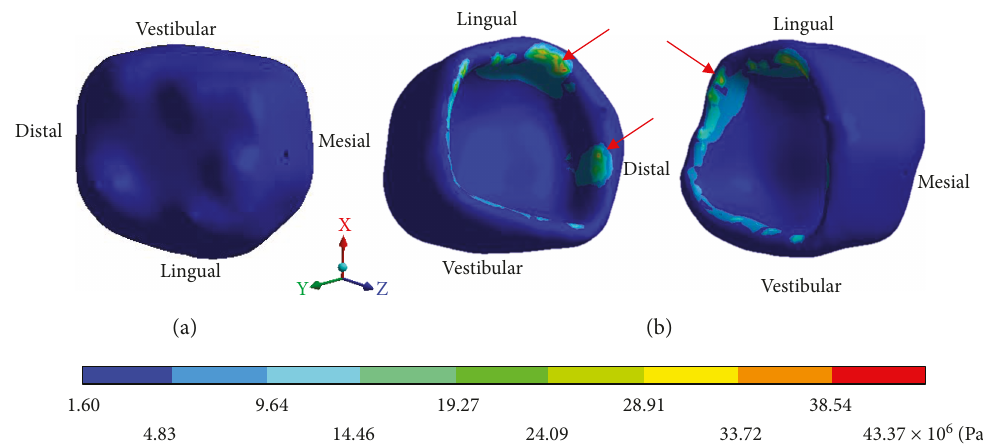
Figure 15: 3rd degree caries : von Mises stresses in enamel: (a) occlusal view (b) cervical view.